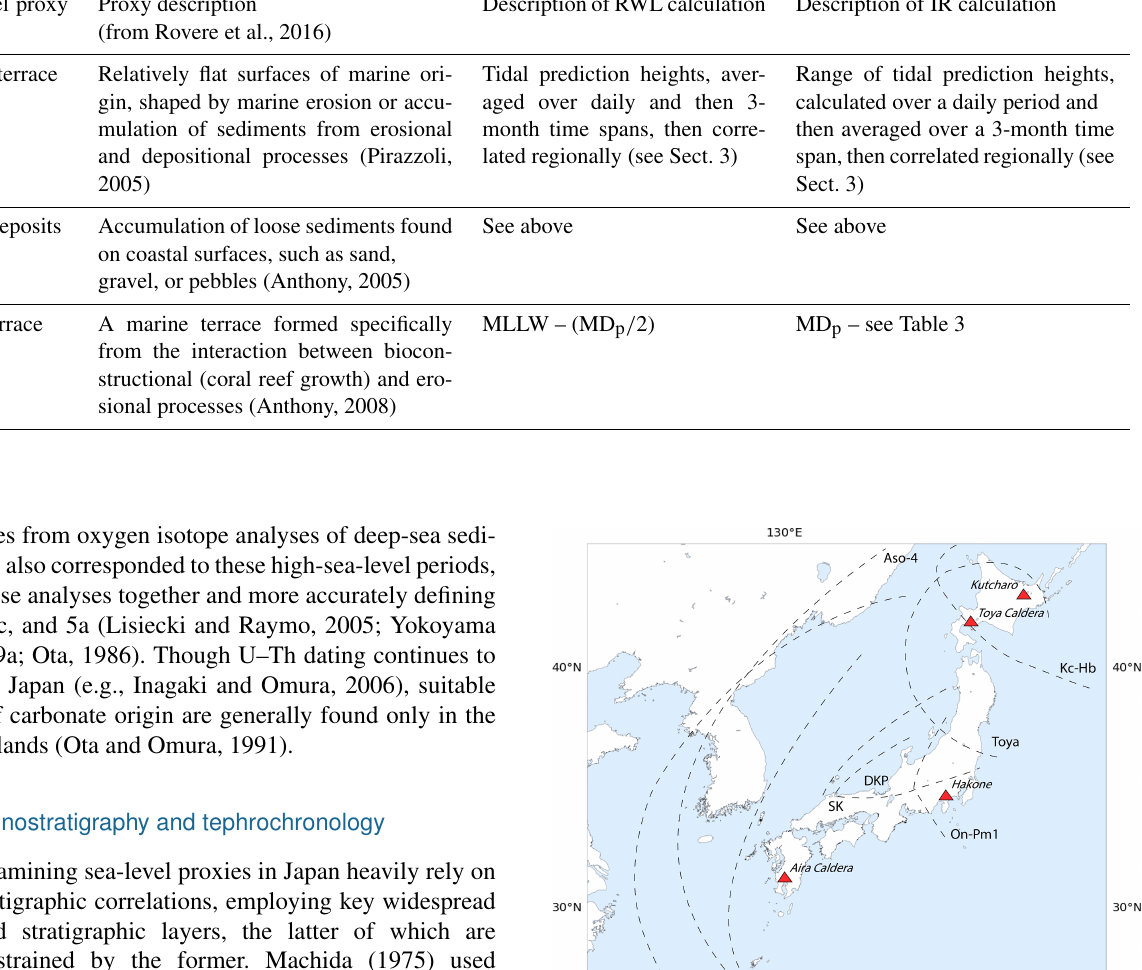
Table 1. Varieties of sea-level proxies identified in this study. Sea-level proxy